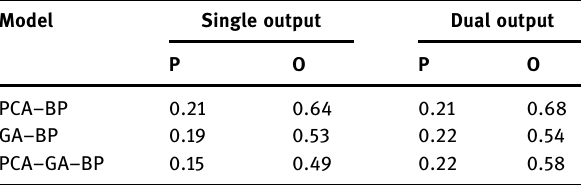
Table 5: RMSE ( 10 − 2 ) comparison of di ff erent models Model